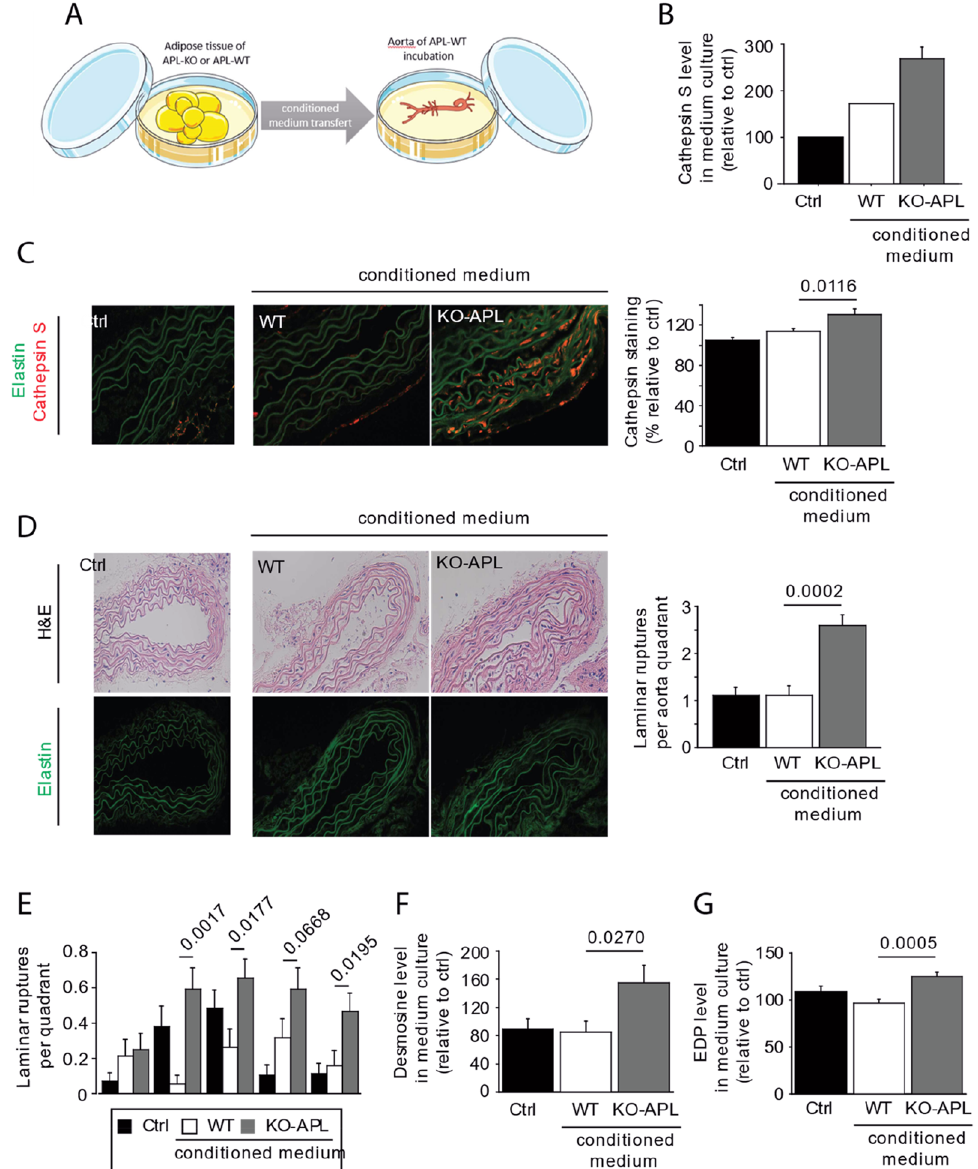
Figure 6. Effects of conditioned medium obtained from visceral adipose tissue of Apelin-knockout mice (KO-APL mice, grey bars, n = 4) and wild-type mice (WT, white bar, n = 4) on elastic fiber fragmentation of WT aorta. ( A ) Schematic of the protocol of conditioned medium, applied to the aortas of WT mice. The control condition (Crtl, black bar) corresponded to a medium that had not been in contact with adipocytes. Image was modified from Servier Medical Art, licensed under a Creative Common Attribution 3.0 Generic License. http:// smart. servi er. com/. ( B ) Identification of the activity of cathepsin S in the media after incubation of visceral adipocytes from APL-KO or WT mice but before the incubation with WT aorta. ( C ) Anti-cathepsin S immunostaining in the aorta after 3 days of incubation with the conditioned medium. ( D ) Histology (hematoxylin–eosin [H&E]) and autofluorescence of aorta elastin after 3 days of incubation with the conditioned medium. ( E ) Number of laminar ruptures per quadrant after 3 days of incubation with the conditioned medium. ( F ) Desmosine level found in culture medium, after 3 days of incubation with the conditioned medium ( G ) Elastin-derived peptide (EDP) level found in culture medium, after 3 days of incubation with the conditioned